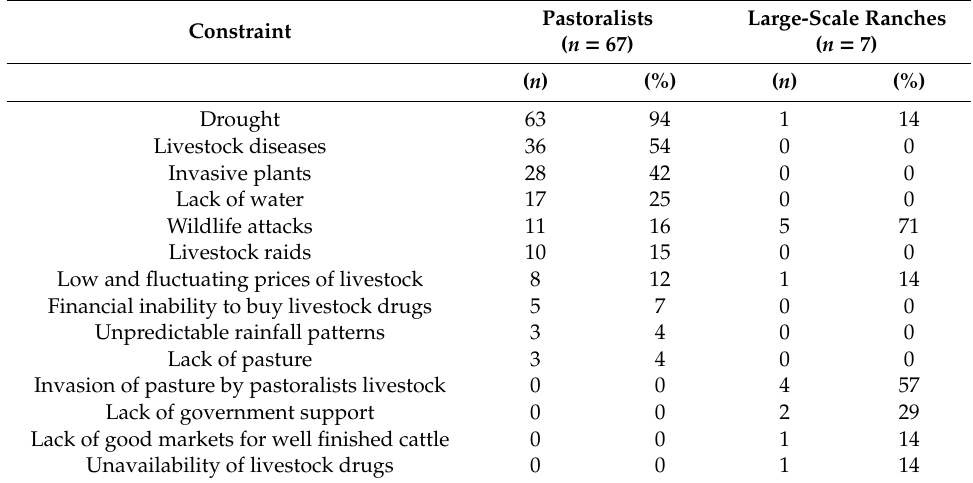
Table 3. Constraints to production identified by pastoralists and large-scale